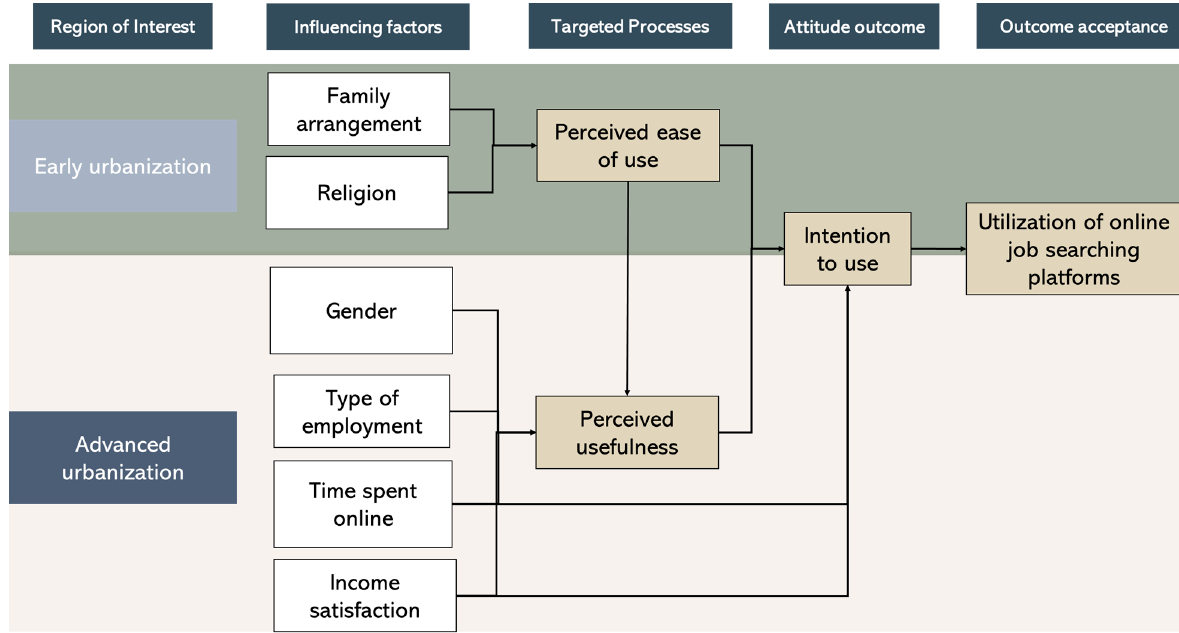
Figure 1. Recommended framework for implementation of policies to enhance older population’s use of the Internet while searching for suitable employment based on levels of urbanization of the local community. Source: developed by authors.